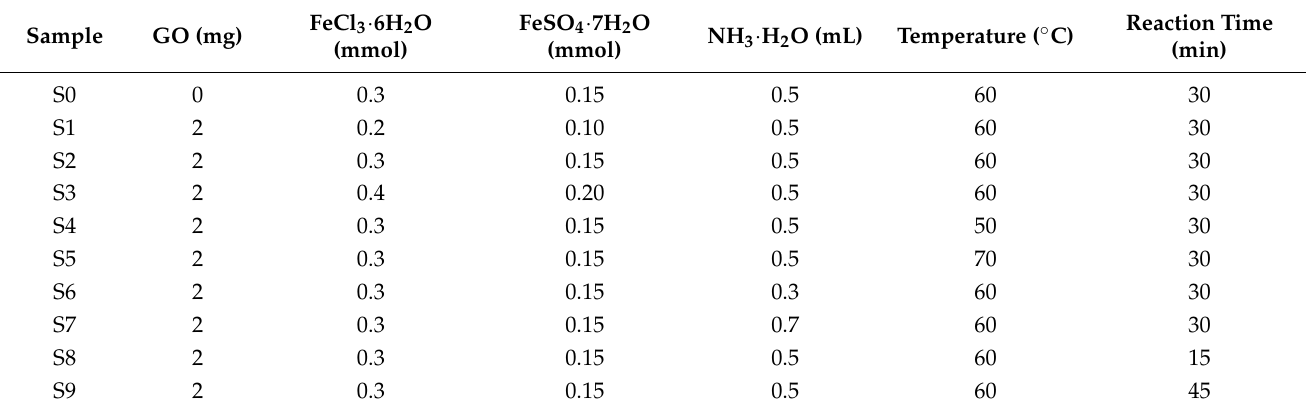
Figure 2. The preparation route of GO@Fe 3 O 4 nanocomposites. Table 1. Experimental parameters for the preparation of all the samples.